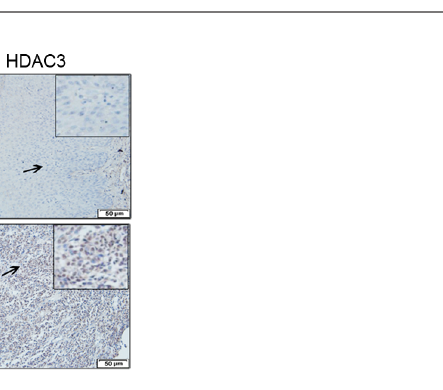
Fig. 1. Increased expression of HDAC3 correlates with lymph node metastasis and clinical stage of melanoma. Immunohistochemistry staining of HDAC3 in human melanoma tissues. Normal and cancer tissues were analyzed by H&E staining (a, b). Negative control of normal and cancer tissues (c, d). The expression of HDAC3 in normal and cancer tissues (e, f). Bar 5 50 m m (magnification, 6 200). Insets showed enlarged views (magnification, 6 400).